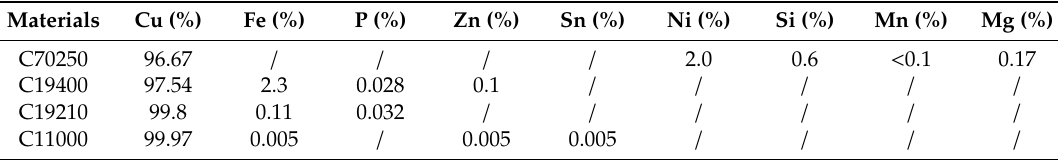
Table 2. Chemical compositions of copper foils used in experiments.